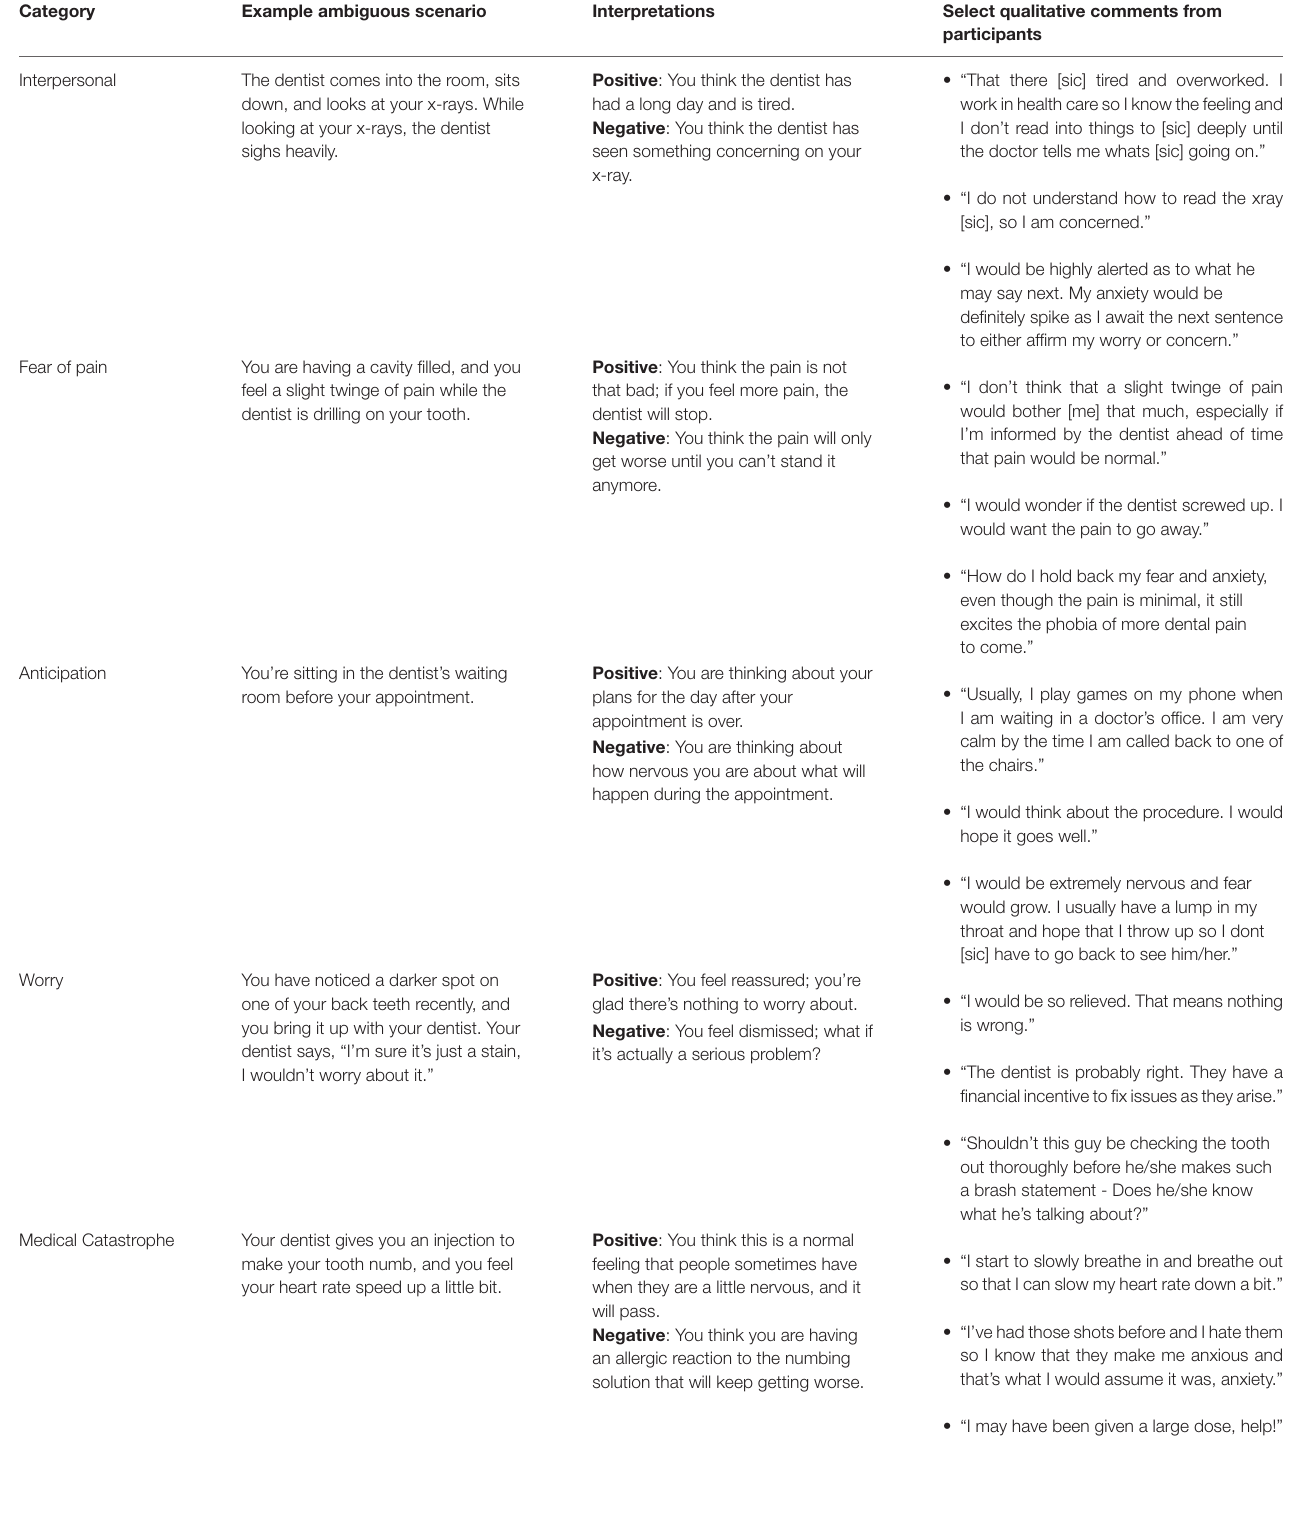
TABLE 1 | Development phase categories, selected ambiguous dental scenarios, interpretations, and qualitative comments.